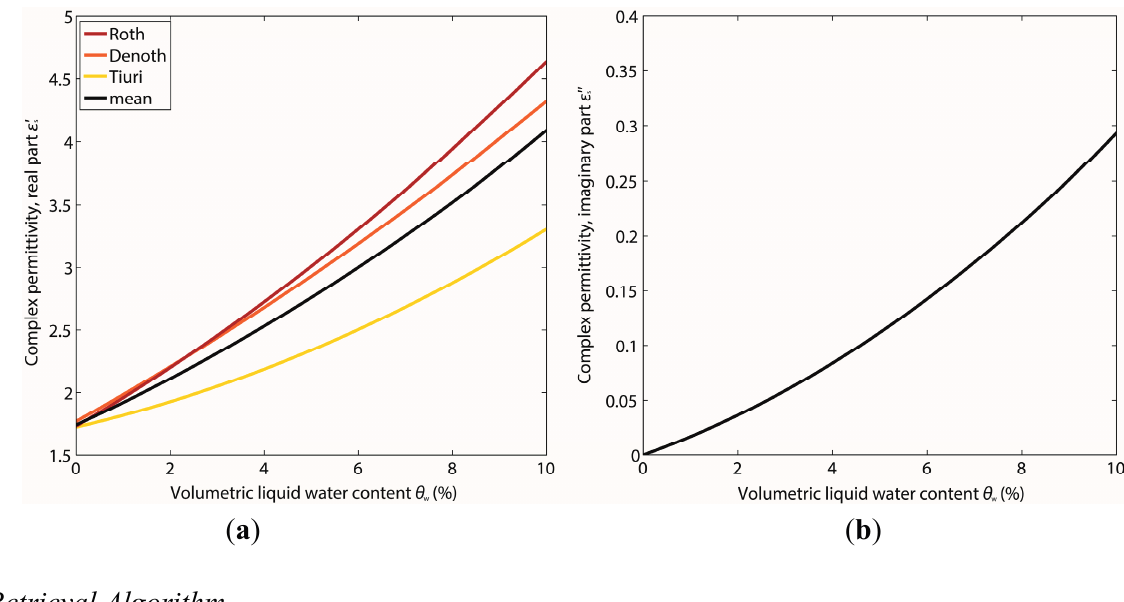
Figure 5. Permittivity vs . liquid water content (LWC) calculated with the three formulations and their mean for ( a ) the real part ε (cid:3046)(cid:4593) and ( b ) the imaginary part ε (cid:3046)(cid:4593)(cid:4593) . The dry snow density was set to 370 kg/m³.